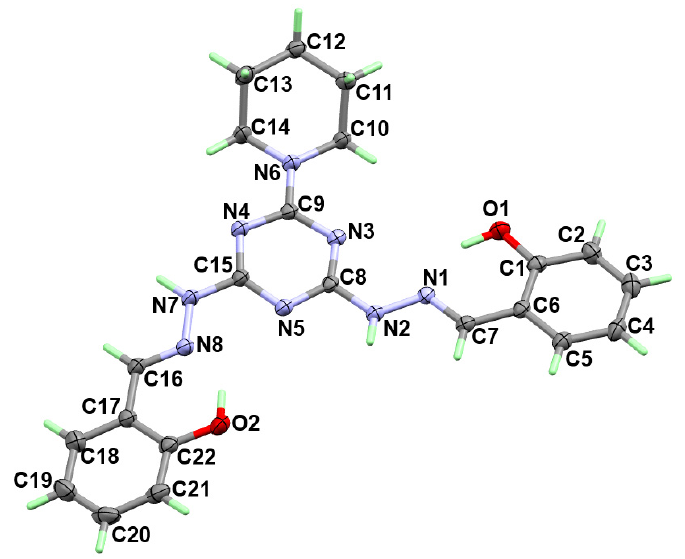
Figure 3. X-ray structure with thermal ellipsoids at 50% probability level for 4 . Table 2. Selected bond lengths [Å] and angles [ ◦ ] for 4